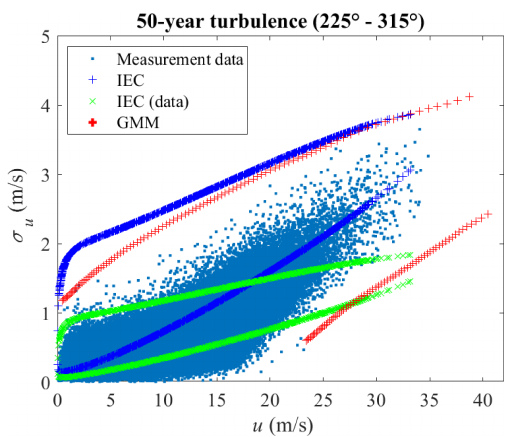
Figure 14. GMM and IEC 50-year turbulence estimation for the offshore